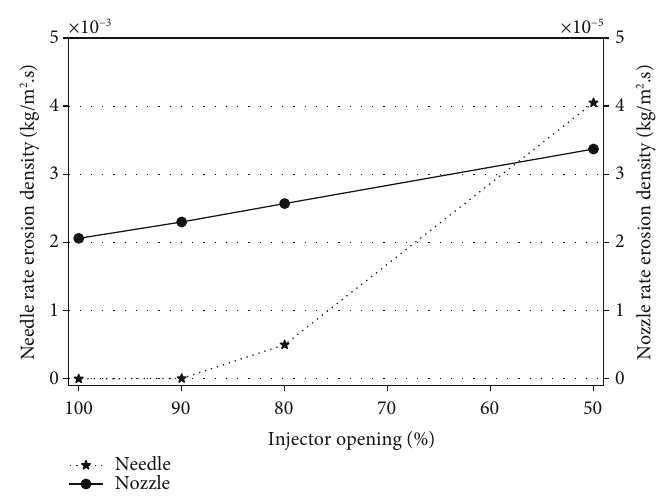
Figure 14: Erosion rate of needle and nozzle for di ff erent nozzle